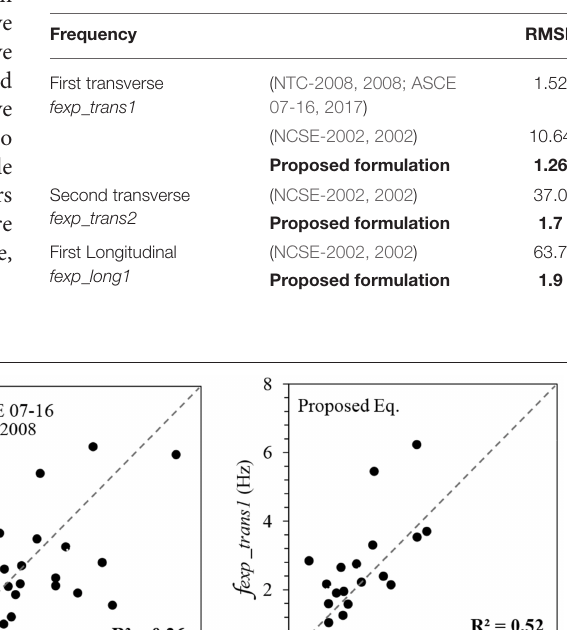
TABLE 4 | RMSE and R 2 coefficients obtained comparing the experimental fexp_trans1, fexp_trans2, and fexp_long1 with the predicted values (Equations 7, 8).